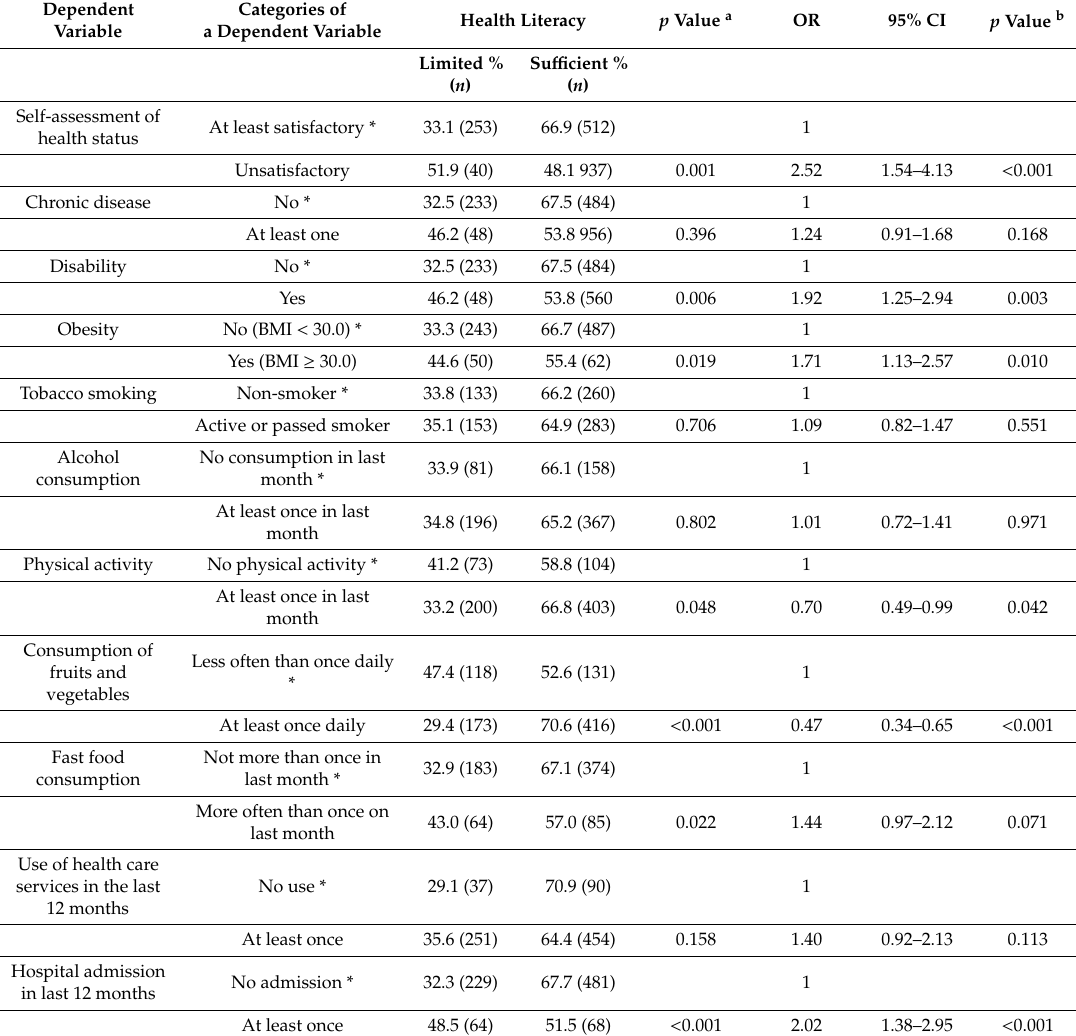
Table 3. The analysis of potential consequences of limited HL (chi2 independence test and multivariate logistic regression models adjusted for sex, age, and education